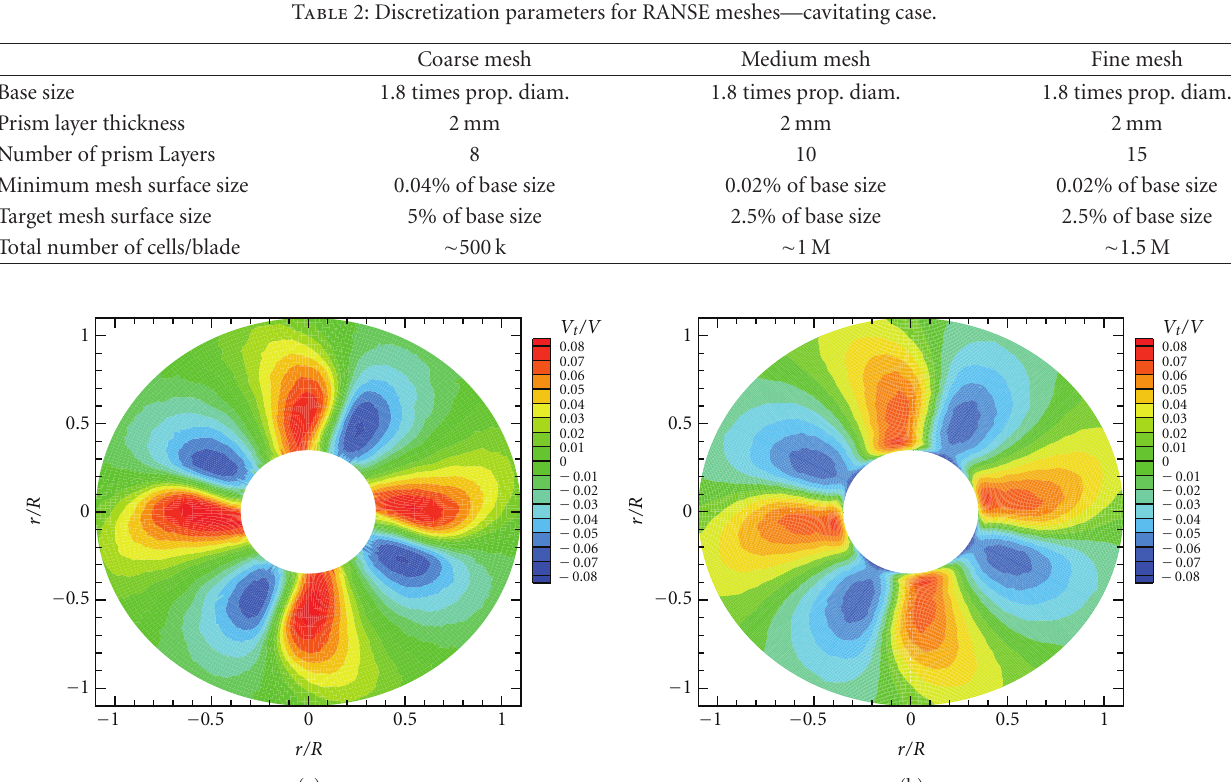
Table 2: Discretization parameters for RANSE meshes—cavitating case.